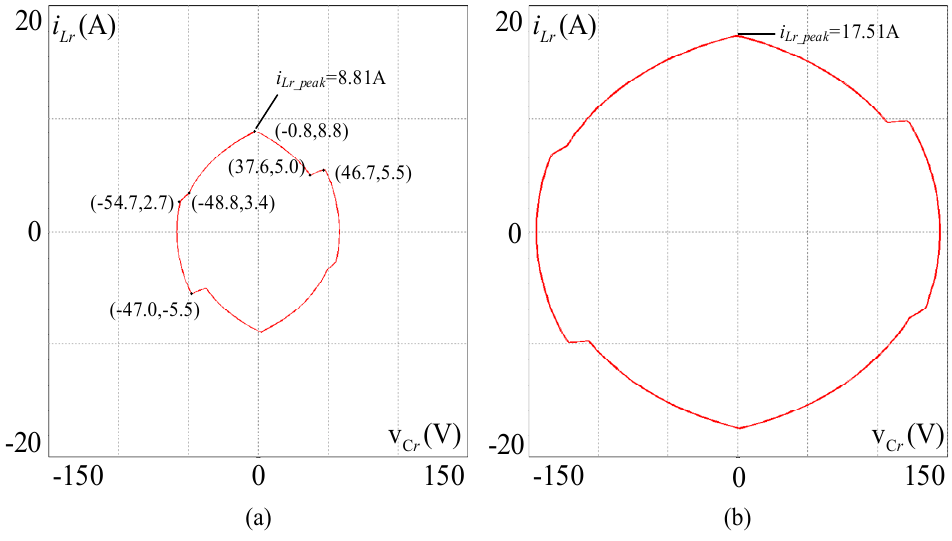
shows the efficiency from light load to 100% load. The highest efficiency point is 96.57%, and